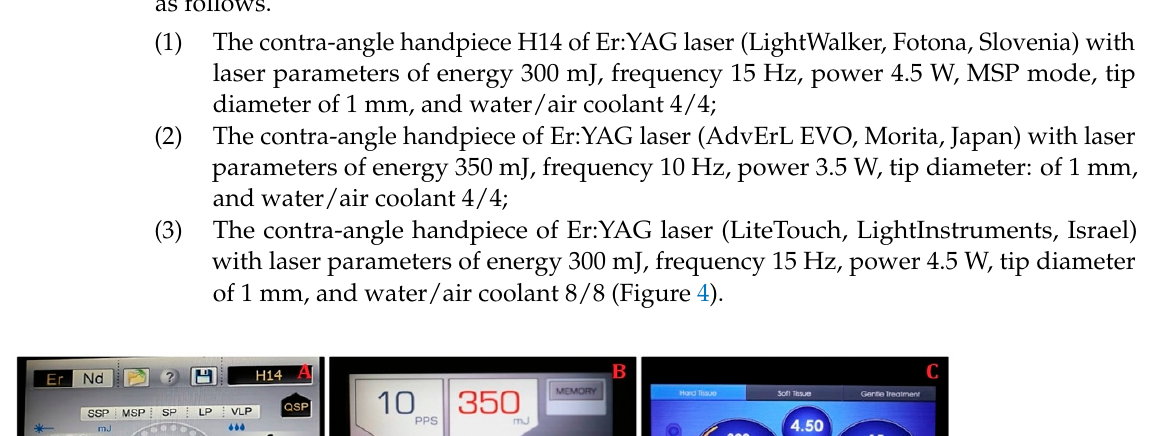
Figure 3. Caries’ removal by conventional handpieces and Er:YAG lasers: ( A ) a high-speed handpiece; ( B ) a low-speed handpiece; ( C ) LightWalker; ( D ) AdvErL Evo; ( E ) LiteTouch.